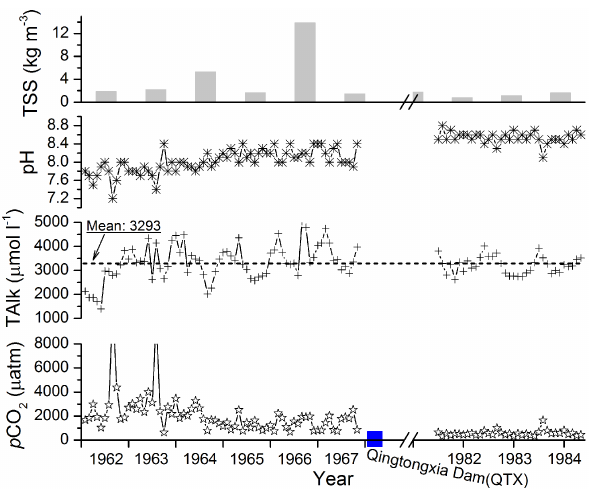
Figure 8. Impacts of Qingtongxia (QTX) dam on riverine TSS, pH, TAlk and p CO 2 . Measurements were conducted ∼ 850m down- stream of the dam that was built in 1968 (see Fig. 1 for its